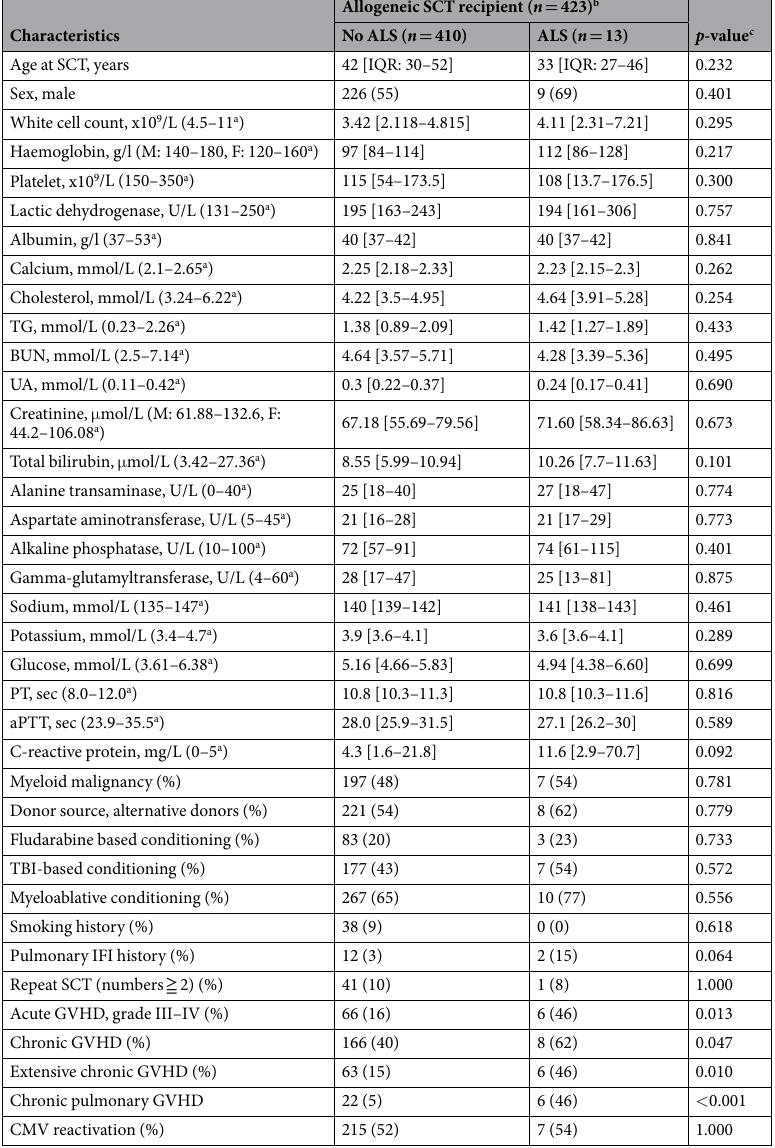
Table 1. Baseline characteristics of adult patients receiving allogeneic SCT. SCT, stem cell transplantation; ALS, air-leak syndrome; TG, triacylglycerol; BUN, blood urea nitrogen; UA, uric acid; PT, prothrombin time; aPTT, activated partial thromboplastin time; TBI, total body irradiation; IFI, invasive fungal infection; GVHD, graft-versus-host disease; CMV, cytomegalovirus. a Normal range. b Values are reported as the median [IQR (interquartile-range)] or n (%). c Determined using the Mann–Whitney U test for quantitative data and Fisher exact test for categorical